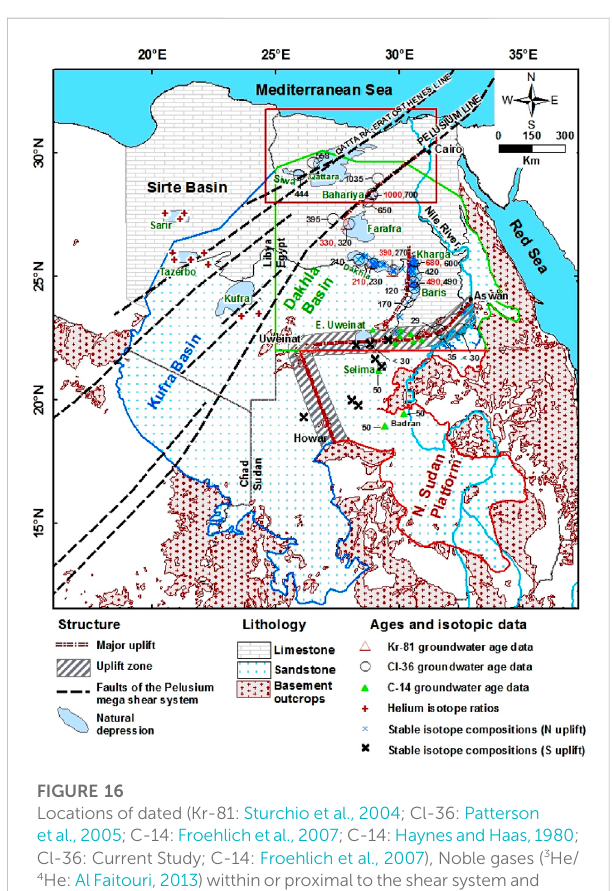
FIGURE 16 Locations of dated (Kr-81: Sturchio et al., 2004; Cl-36: Patterson etal.,2005;C-14:Froehlichetal.,2007;C-14:HaynesandHaas,1980; Cl-36: Current Study; C-14: Froehlich et al., 2007), Noble gases ( 3 He/ 4 He:AlFaitouri,2013)witthinorproximaltotheshearsystemand isotopically (O, H) analyzed groundwater samples north and south of the Uweinat – Aswan uplift. Red box shows studies in Figure 17A. FIGURE 17